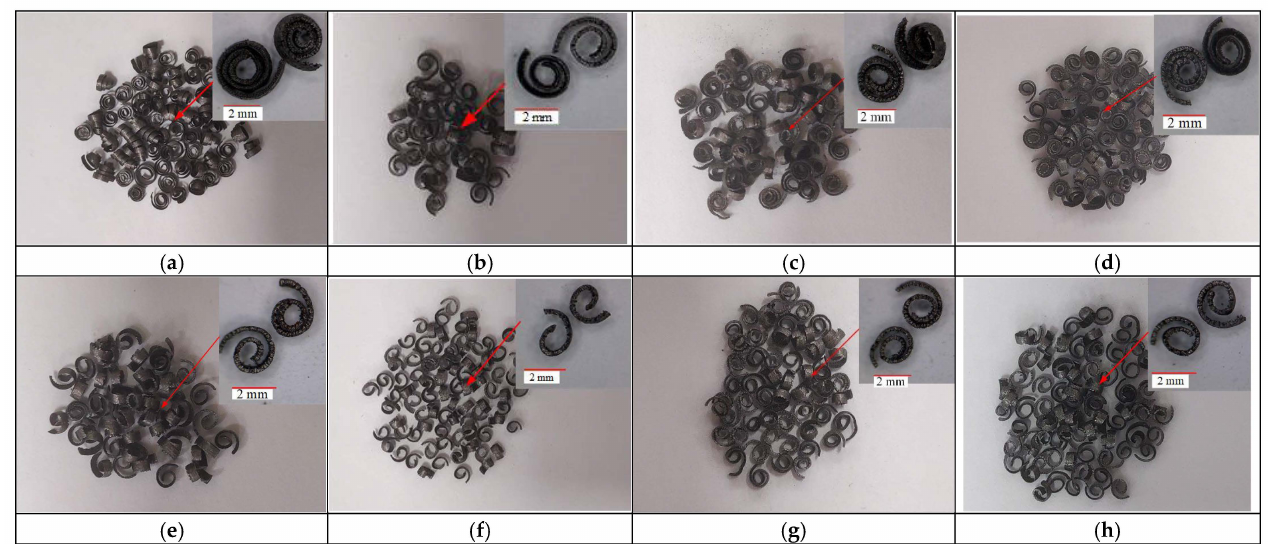
Figure 14. Chip morphology under different cutting conditions. ( a ) Vc = 60